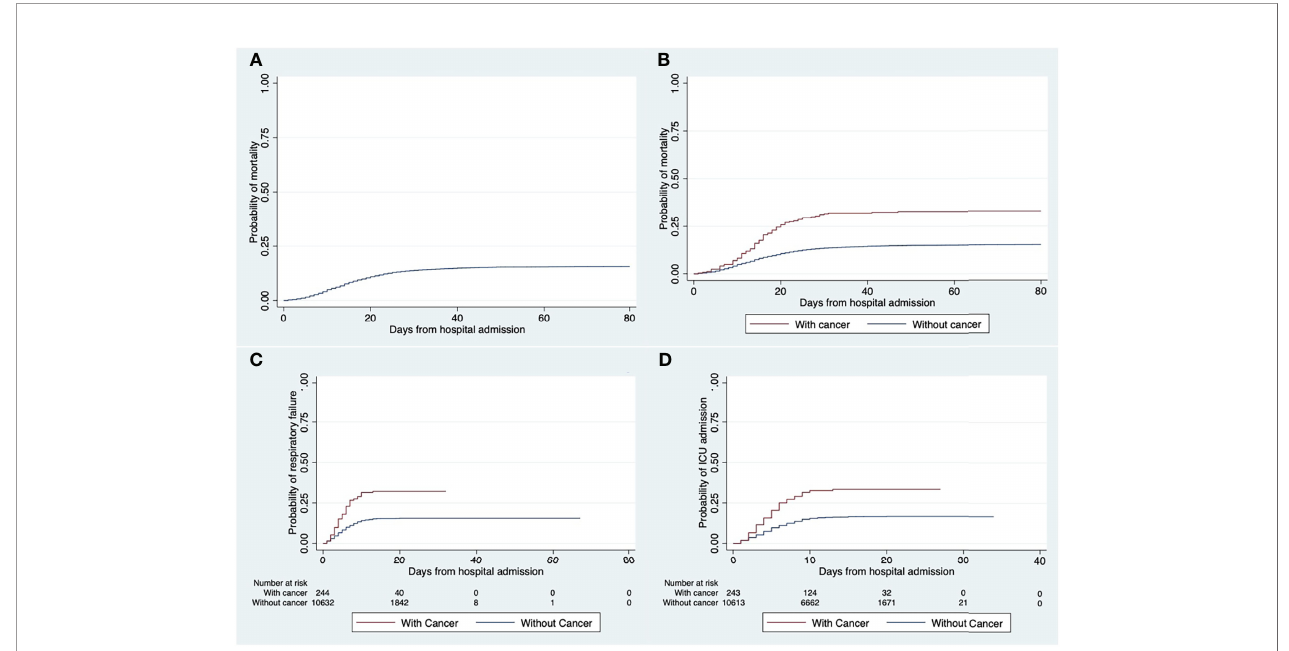
FIGURE 2 | Kaplan-Meier failure plot of the full cohort (A) , and the comparison of the probability of (B) mortality, (C) respiratory failure, and (D) ICU admission, between COVID-19 patients with and without